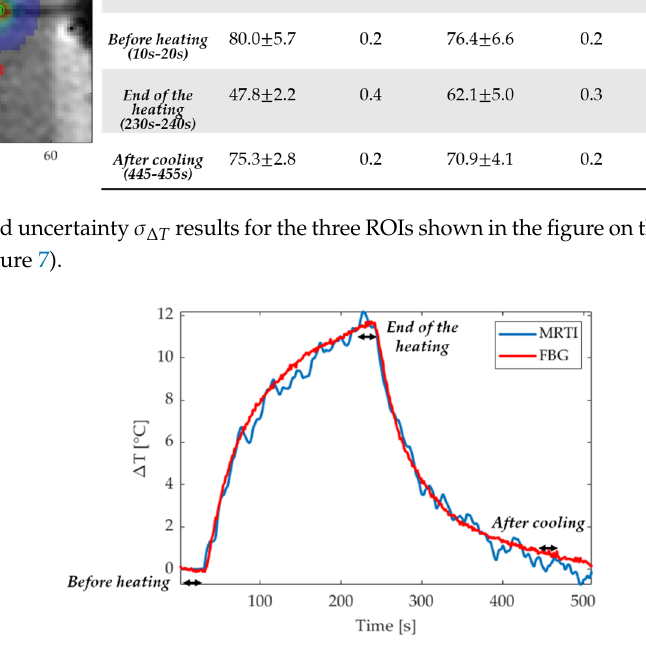
Figure 8. ROI in the MRTI images for the analysis and comparison between FBG and MRTI space temperature lines for 5 tests.